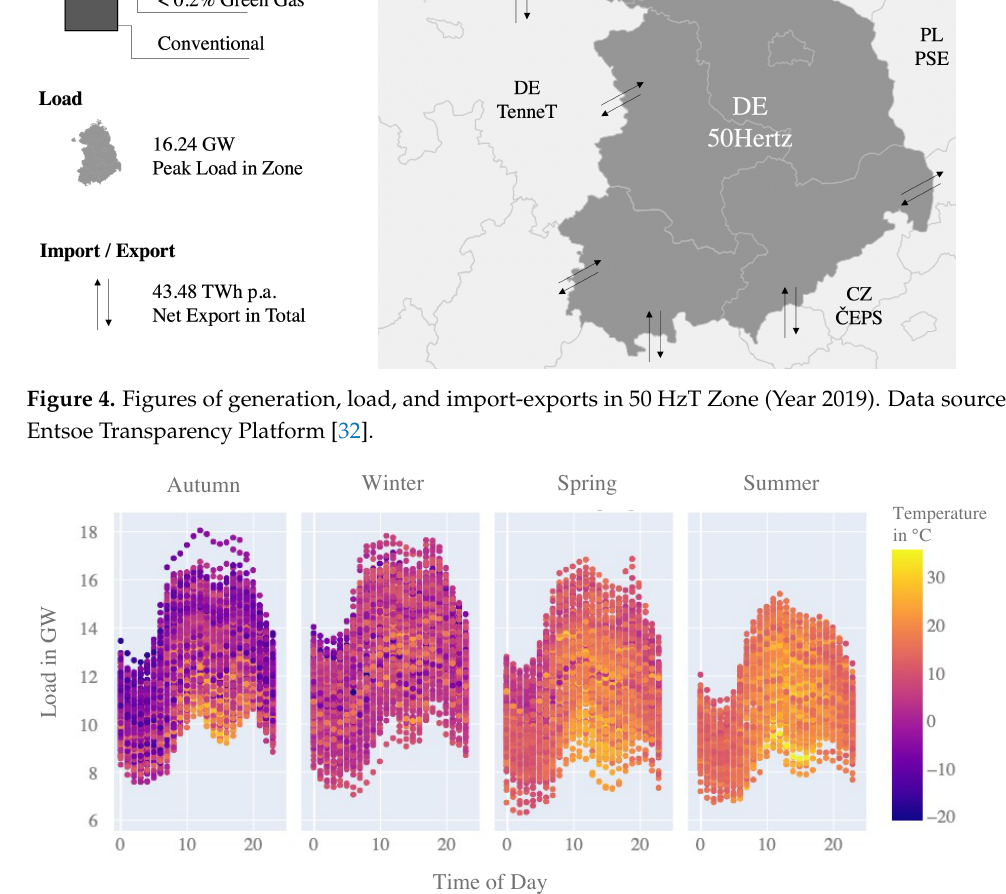
Figure 5. Average net load profiles per season from October 2018 to December 2021. See: Entsoe Transparency Platform